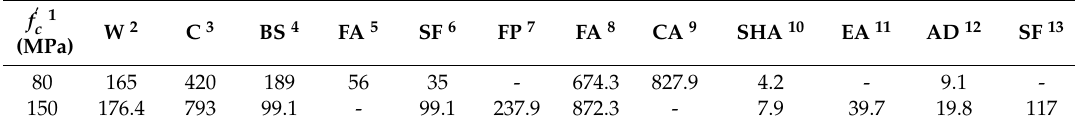
Table 1. Mix proportion of precast concrete. Unit: kg / m 3